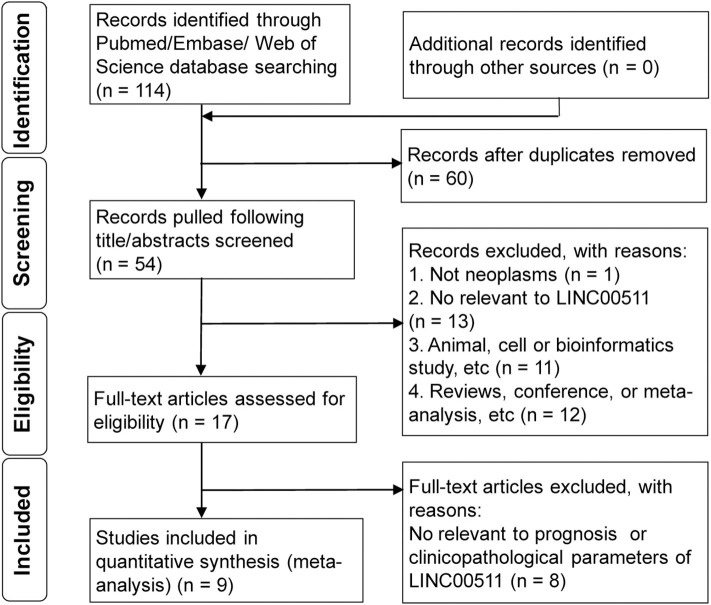
The flow diagram of this meta-analysis.